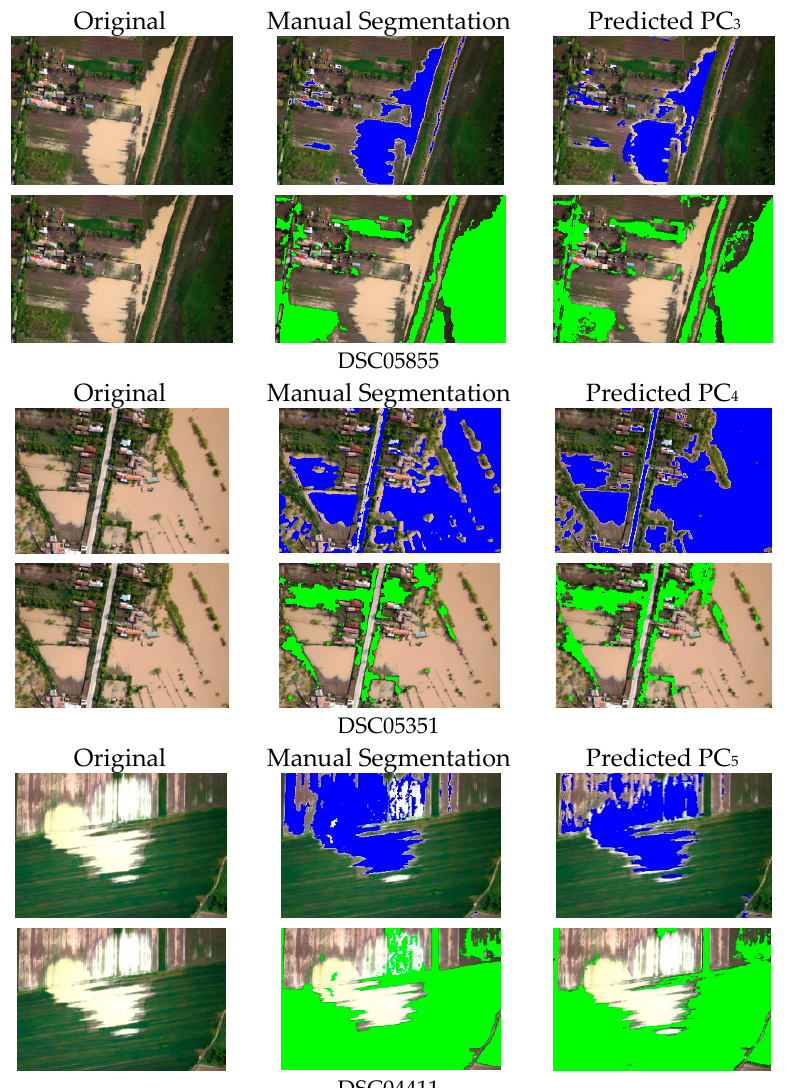
Figure 14. Flood and vegetation segmentation (manual and predicted) for individual classifiers (validation phase)—our dataset. Remote Sens. 2020 , 12 , x FOR PEER REVIEW